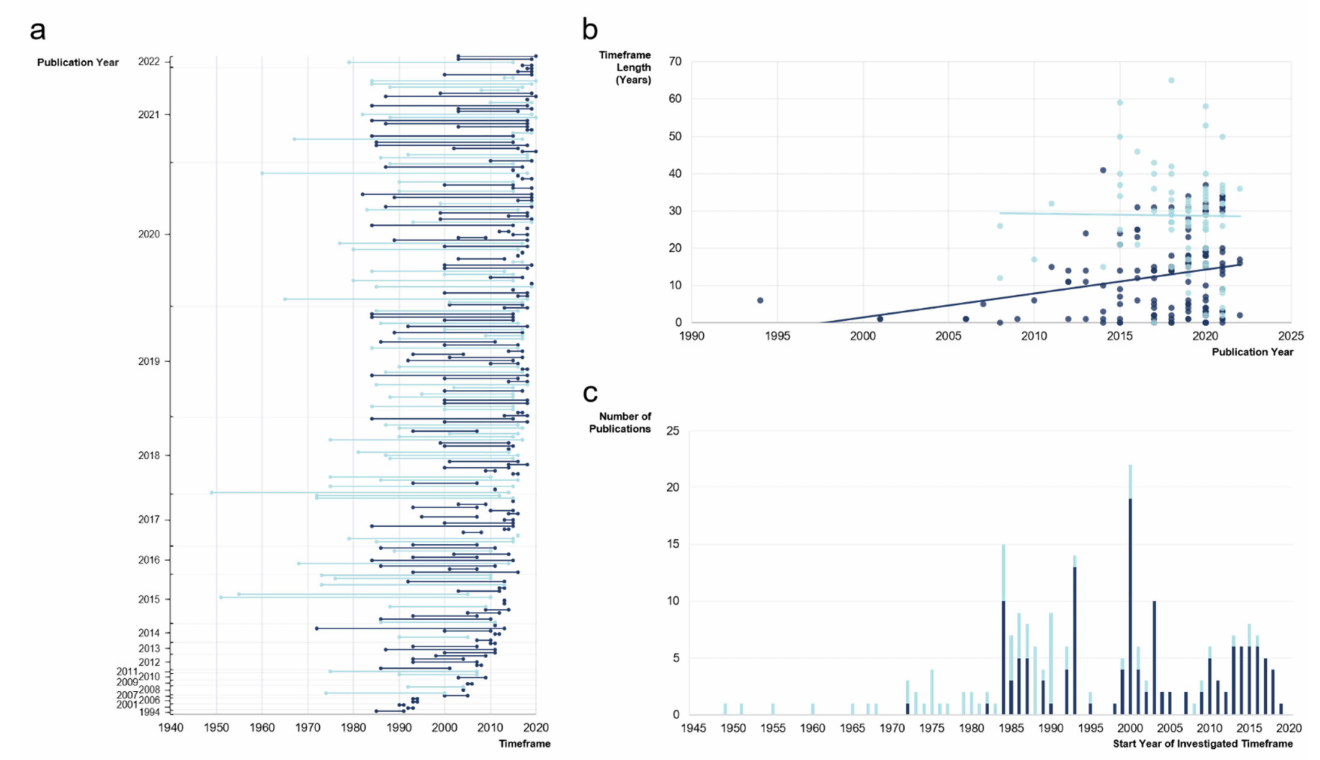
Figure 5. ( a ) Overview of investigated timeframes in reviewed publications. ( b ) Development of investigated timeframe lengths over the years. ( c ) Frequency and distribution of start years of investigated timeframes. Points signify studies, the general trend can be discerned from linearly fitted lines. Studies are color coded to show whether they did or did not consider intra-annual dynamics (dark and light blue,